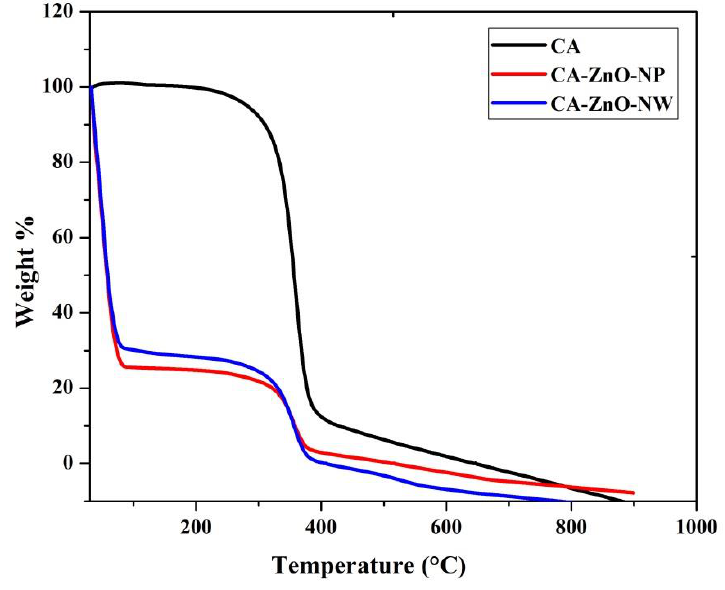
Figure 5. TGA data of the pristine CA membrane, the CA-ZnO-NP membrane, and the CA-ZnO- NW membrane.